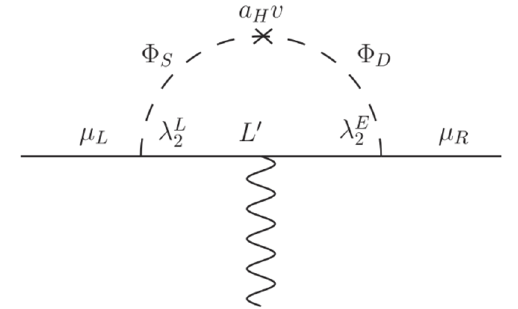
(cid:16) (cid:17) (cid:21) Q ; Im( (cid:21) U ) plane, for (cid:21) Q = (cid:0) 1 : 5. The other parameters were set as in (cid:12)gure 3. 1 2 3